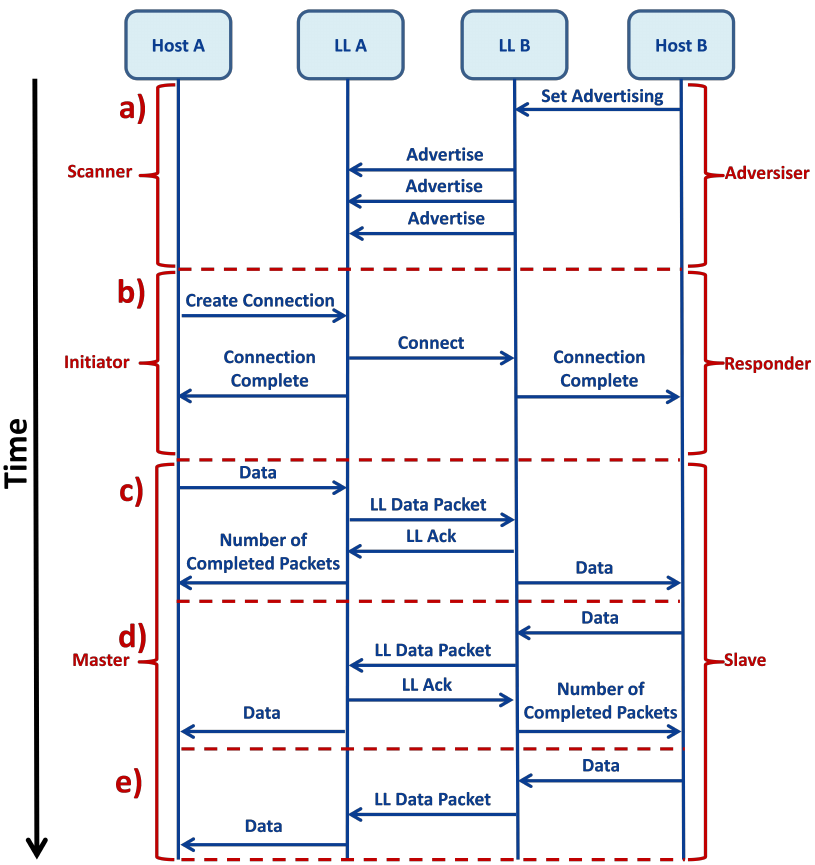
Figure 7. This figure shows how two devices (A and B) communicate through BLE. The two vertical blue lines on the left represent the Host layer and the LL of the device A, while the two lines on the right represent the same two layers relative to the device B. Blue arrows represent the communication messages between layers and devices. The black arrow on the left shows that the time increments scrolling the figure to the bottom. Red braces indicate the specific role of the devices A and B during the different parts of the communication. Part ( a ) of the figure shows the advertising mechanism, in which the advertiser (B) sends a message from the Host to the LL in order to enable the sending of advertising packets. The scanner (A) receives these packets and prepares itself for the connection . In ( b ) is shown the connection establishment where the initiator (A) sends a message in order to create the connection , firstly from the Host to its own LL and then to the other device, the responder (B). At the end, if the connection is established correctly, the two LLs send a message to the respective Host layers in order to confirm the correct creation of the connection . Starting from ( c ), the connection is created, and the two devices are called master (A) and slave (B). In ( c ), the master sends data packets to the slave , writing on a writable characteristic . In this case, data packets are sent from the master Host layer to its own LL and then to the slave . During this process, an Acknowledgment packet (ACK) is sent back to the master in order to communicate to the Host layer if and how many packets were correctly transmitted. This type of communication, with the ACK packet, is called round-trip . A similar process is shown in ( d ), where the slave writes on its readable characteristics and the master reads the data. Also in this type of communication, there is the transmission of an ACK packet, so this is also a round-trip communication. In ( e ), a one-way communication is represented, where the slave communicates with the master using a notifiable characteristic , which means there is no ACK